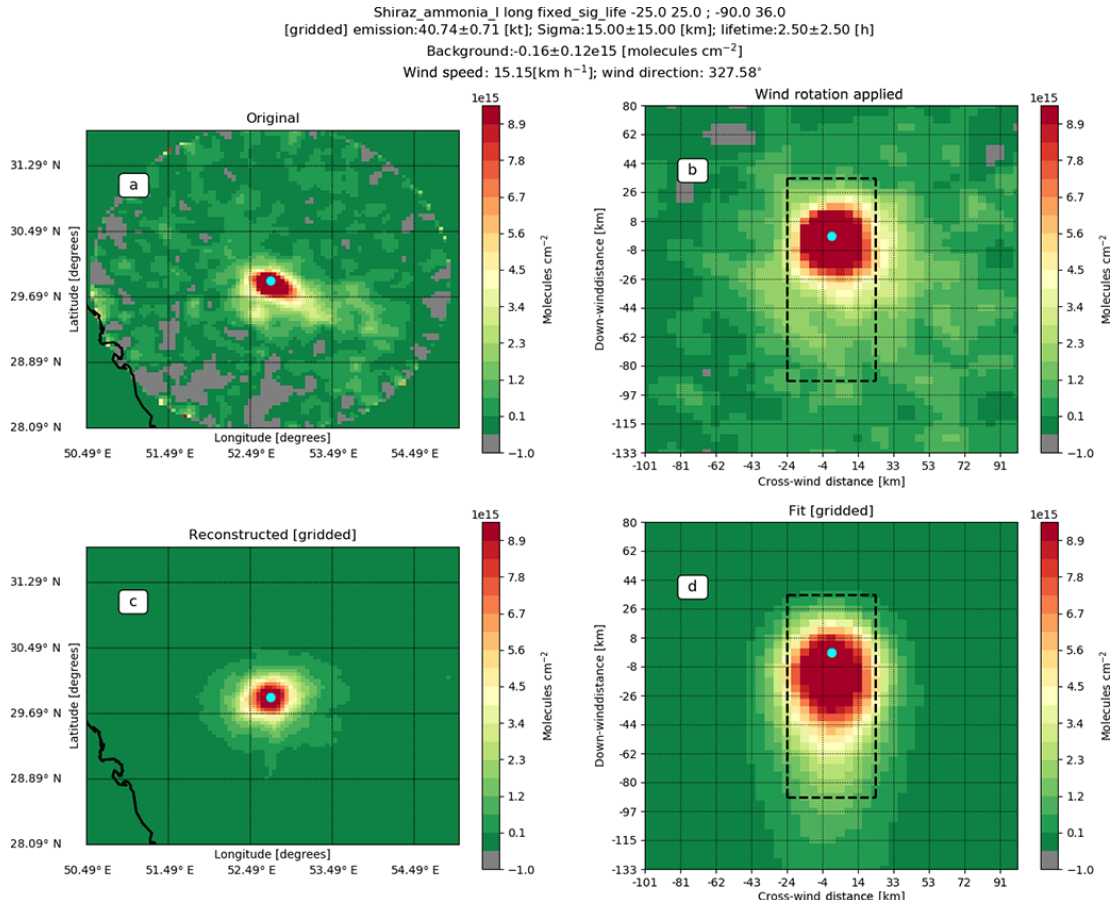
Figure D2. Fit example for the fertilizer plants in Shiraz, Iran. Panel (a) shows the original IASI-B NH 3 total columns (2013–2017) gridded at a 0.05 ◦ × 0.04 ◦ (long, lat) resolution with the pixel-averaging technique with a 15km radius to represent the footprint. Panel (b) shows the same observations after applying the wind rotation algorithm and gridding the observations to a 3km × 4.5km grid. Panel (d) shows the fit to the observations and (c) the reconstruction of the initial plot using the parameters found in the